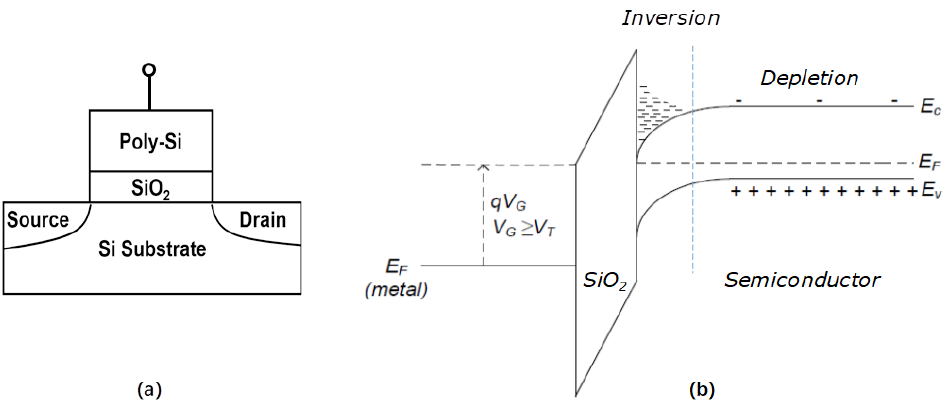
Figure 1. MOSFET ( a ) and its energy band structure ( b ), where q is the carrier density, V G the gate voltage, V t the threshold voltage, E f the fermi level, E c and E v the conduction band and valence band edges, respectively.